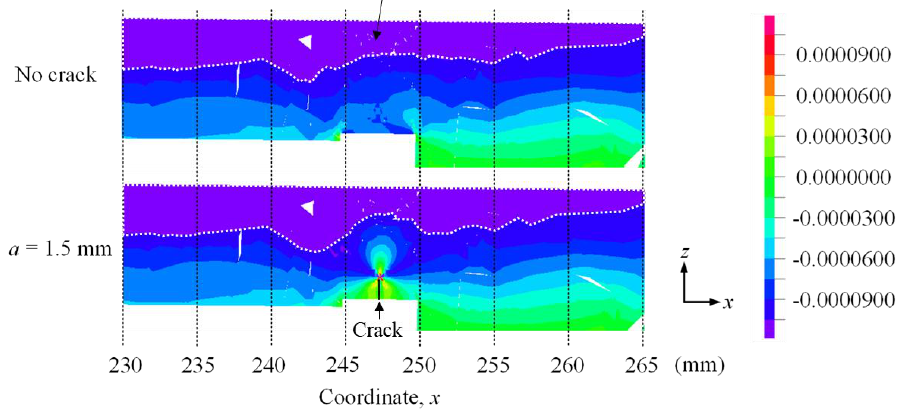
Figure 15. The strain distribution ( ε z ) of Model 3D, a = 0, 1.5 mm.